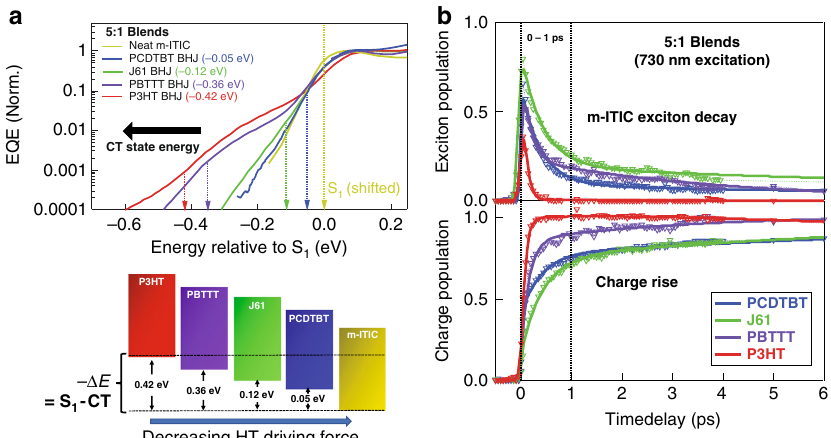
Fig. 3 Driving force dependent sub-picosecond HT in polymer:m-ITIC blends. a sEQE spectra for the polymer:m-ITIC 5:1 blends and neat m-ITIC. The curves are shifted to always have the m-ITIC S 1 energy (from a bi-Gaussian fi t of the sEQE and EL data) at 0 eV for better comparison. At the bottom, a schematic illustration of the driving forces for HT in polymer:m-ITIC 5:1 BHJ samples is shown. b m-ITIC exciton decay (top) and charge rise (bottom) dynamics for polymer:m-ITIC 5:1 BHJ samples, upon selective m-ITIC excitation at 730 nm, obtained from the analysis of the TA data. The y -axis is expressed as a fraction of the total absorbed photon density. Symbols are the experimental data and solid lines are exponential fi ts obtained globally for the exciton decay and charge rise.